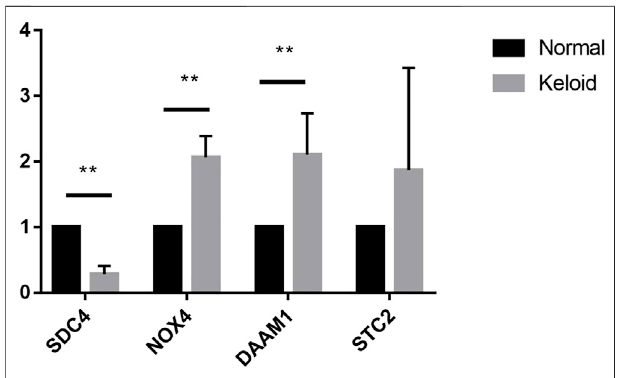
FIGURE 8 | The expression differences of SDC4, NOX4, DAAM1, STC2 between keloid fi broblasts and normal skin fi broblasts. (Note: **compared the keloid tissues with the normal human skin tissues. p <